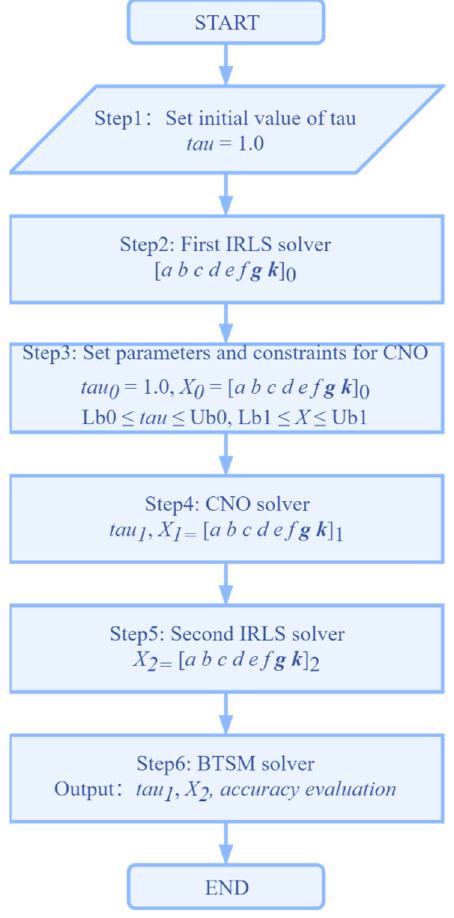
Figure 6. Analysis flow of the integrated time series model.